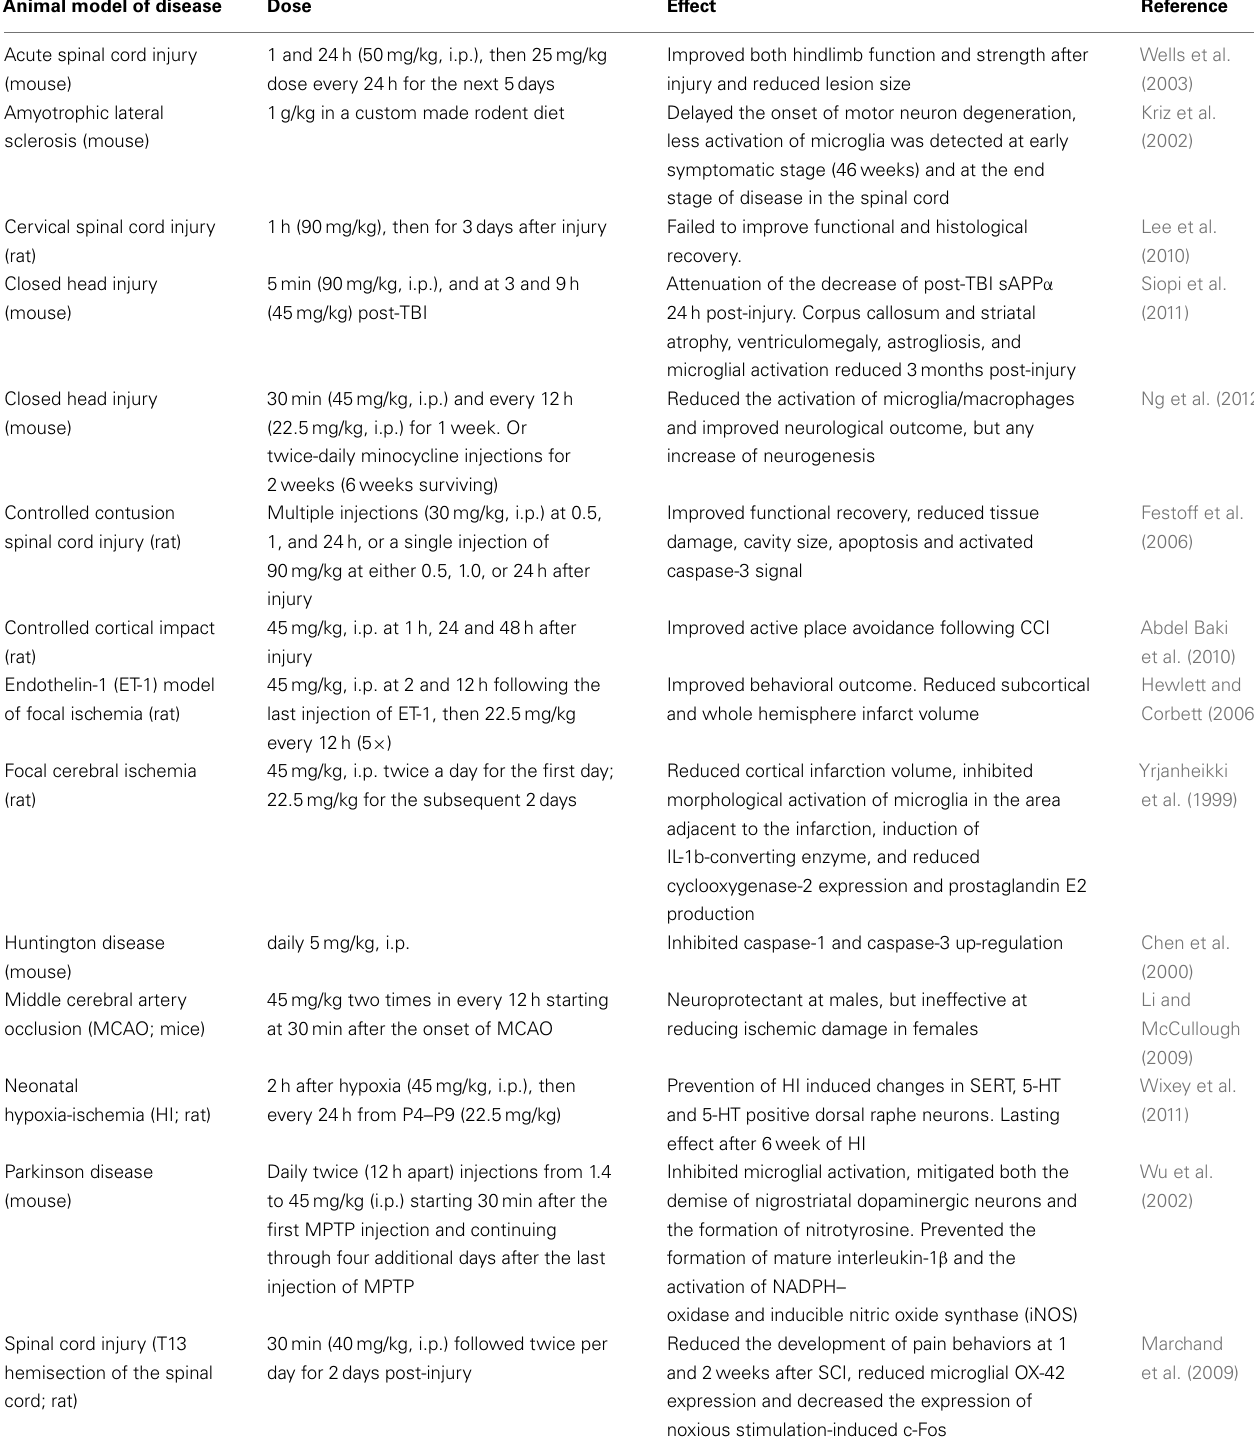
TableA1 | List of animal models of various diseases, dose of minocycline treatment and the observed effects of the treatment. Animal model of